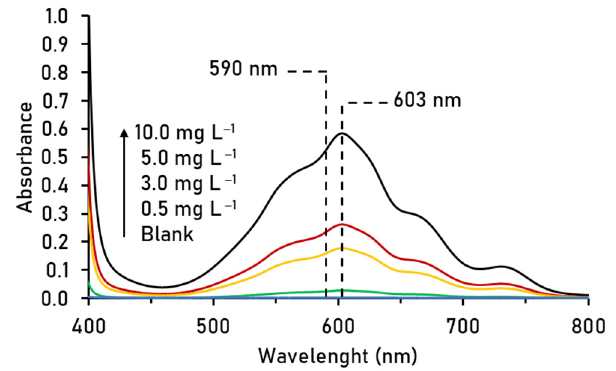
Figure 2. UV–vis spectra of blue product of paraquat free-radical ion.